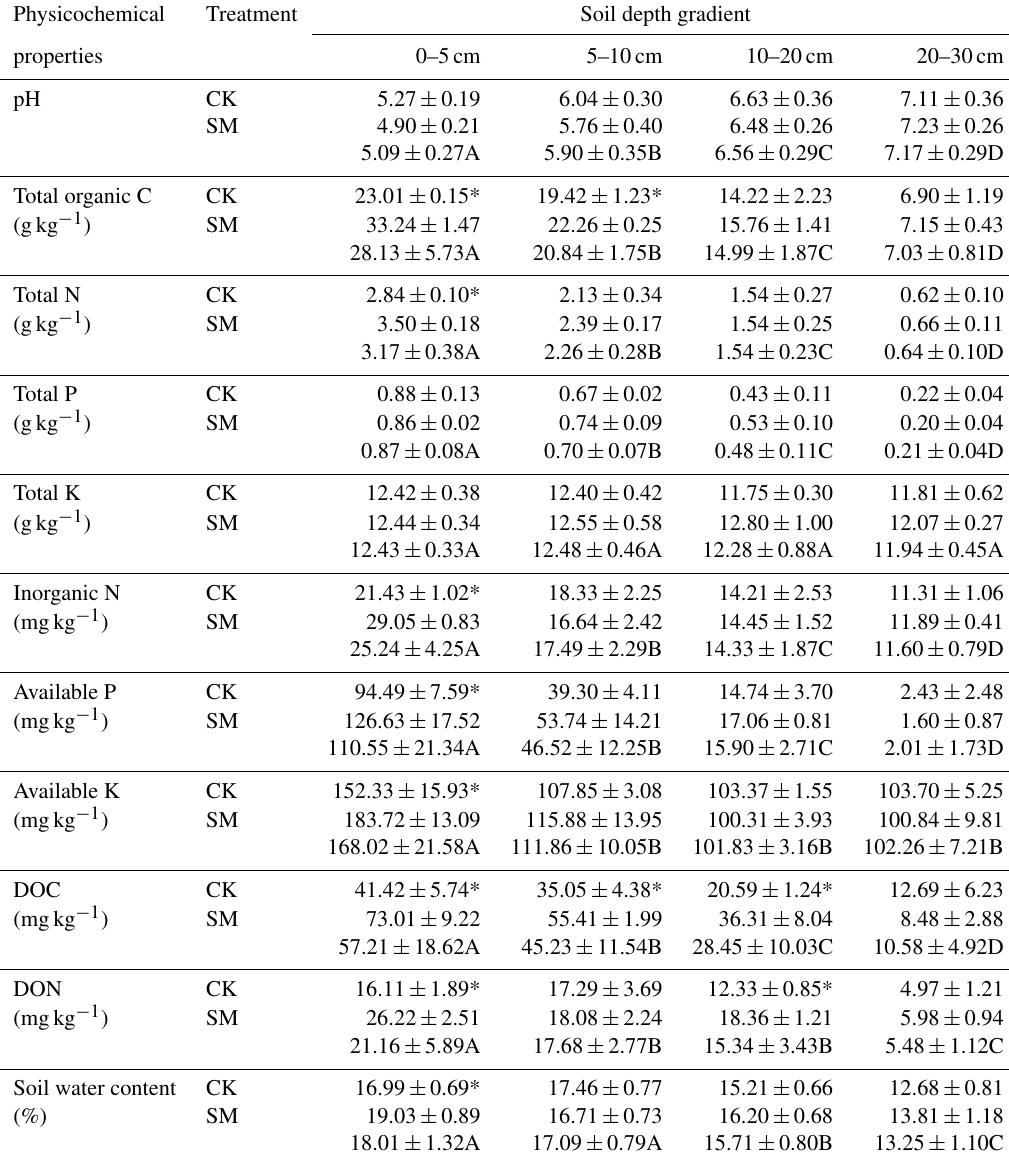
Table 2. Soil physicochemical properties at different soil depths under SM and CK treatment. CK, no-till with straw removal; SM, no-till with straw mulching. Data are means ± standard deviations, n = 3. Different capital letters indicate significant differences ( P < 0.05) among the four depths; ∗ indicates significant differences ( P < 0.05) among the two straw managements within each depth (Duncan’s test). DOC, dissolved organic carbon; DON, dissolved organic